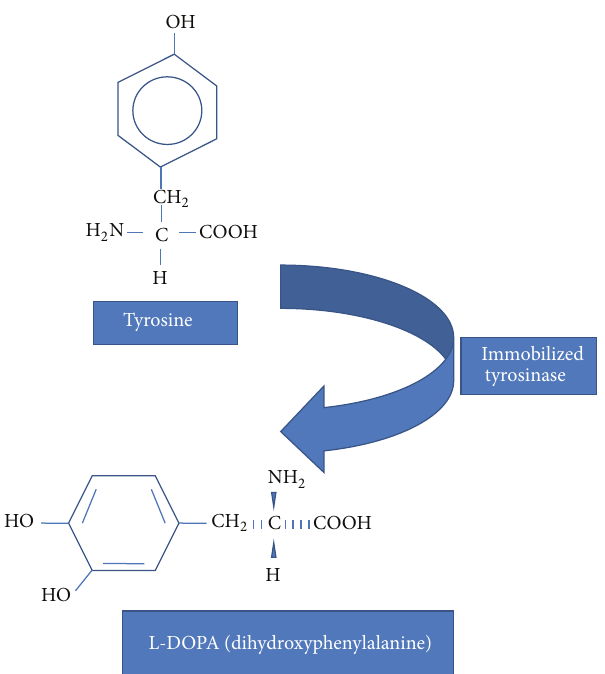
Figure 6: Industrial production of L-DOPA using of microbial